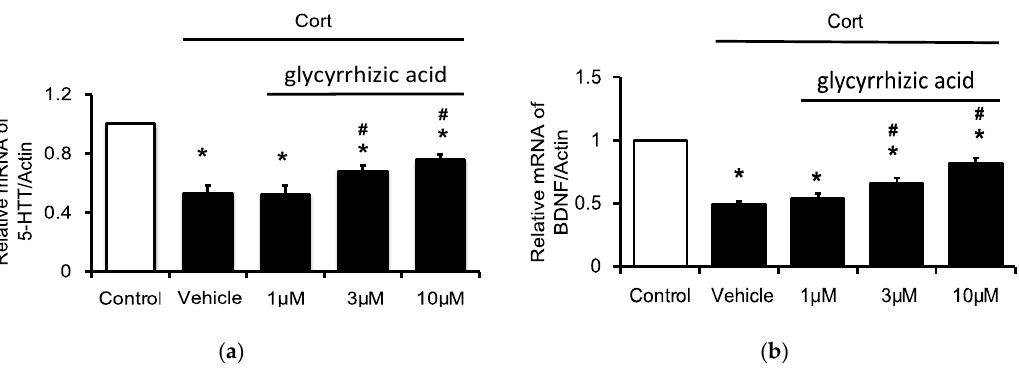
Figure 4. Effects of glycyrrhizic acid (GA) on 5-HTT and BDNF expressions in the corticosterone- treated H19-7 cells. H19-7 cells were incubated under normal differentiating conditions in the pres- ence or absence of corticosterone (Cort) at concentration of 1 μM for five days. Then, cells were respectively incubated with glycyrrhizic acid at 1 μM, 3 μM, or 10 μM for 24 h. ( a ) The mRNA levels of 5-HTT; ( b ) the mRNA levels of BDNF. Data are expressed as mean ± SE ( n = 8). * p < 0.05 compared to the cells without treatment of corticosterone (control). # p < 0.05 compared with the vehicle-treated group.